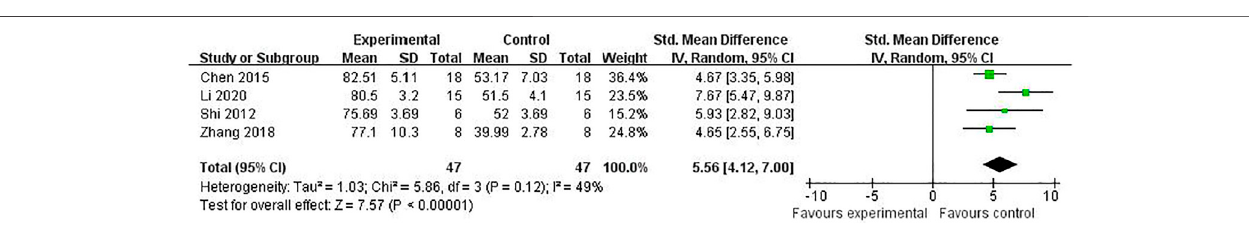
FIGURE 8 | The pooled estimate of RRC for increasing cell viability.